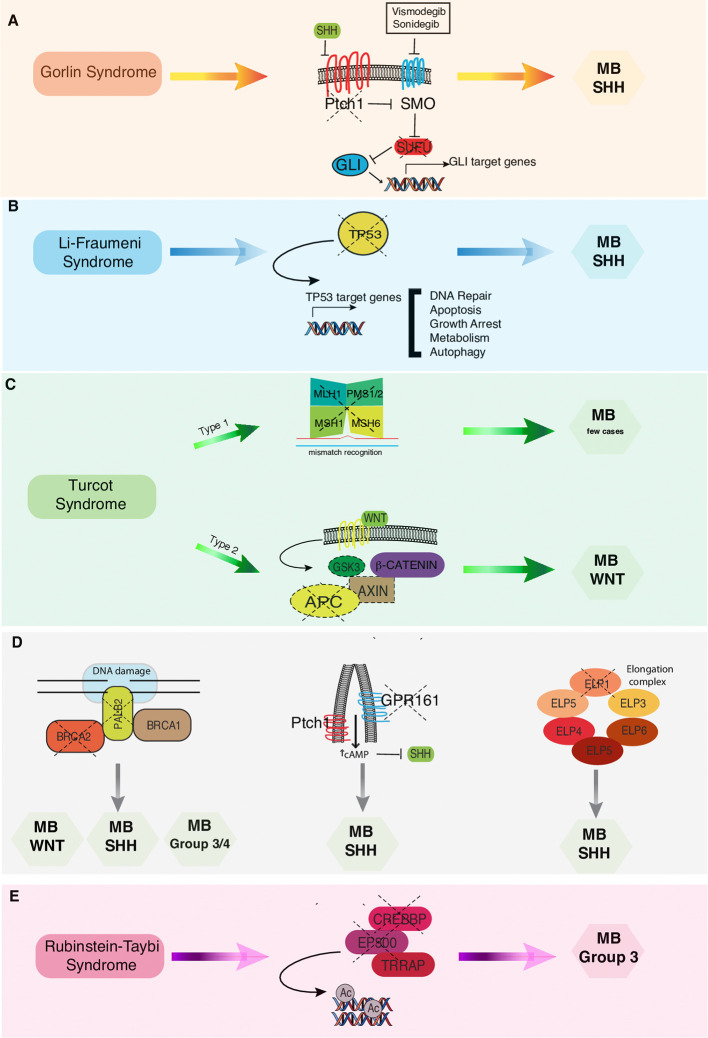
Correlations between cancer predisposition syndromes and MB subtypes. (A) In Gorlin syndrome both PTCH1 and SUFU mutations have been associated to MB-SHH subgroup. Vismodegib and Sonidegib are selective antagonists of the transmembrane activator Smoothened (SMO). (B) In Li-Fraumeni syndrome los of TP53 finctions results in increased risk of developing MB-SHH subtype. (C) In Turcot syndrome, twotypes have been distinguished: Type 1 genetically related to the mutationof the mismatch repair genes and Type 2 related to APC mutation that are more commonly associated with MB-WNT subtype. (D) Pathogenic germline mutations in BRCA2, PALB2, GPR161, and ELP genes have been recently associated to an increased risk of developing different MB subtypes. (E) In Rubenstein-Taybi syndrome mutations in CREEBP and EP300 genes predispose to MB Group 3 onset.